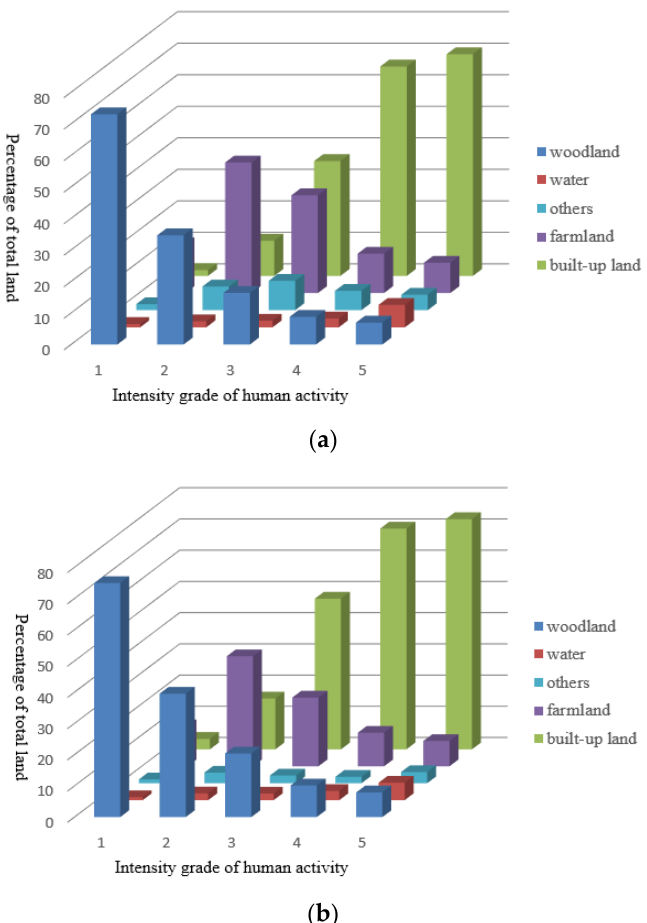
Figure 6. Land percentage for different intensity grades of human activity: ( a ) 2009; ( b ) 2013.